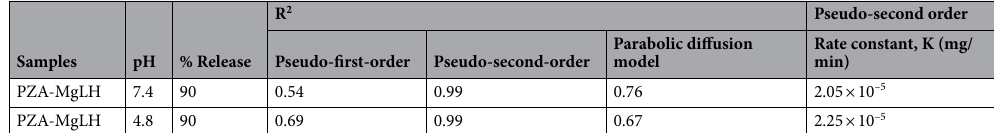
Table 2. Correlation coefficient (R 2 ) and rate constants (k) obtained by fitting data of the release kinetics of PZA from PZA-MgLH into PBS solutions at pH 4.8 and